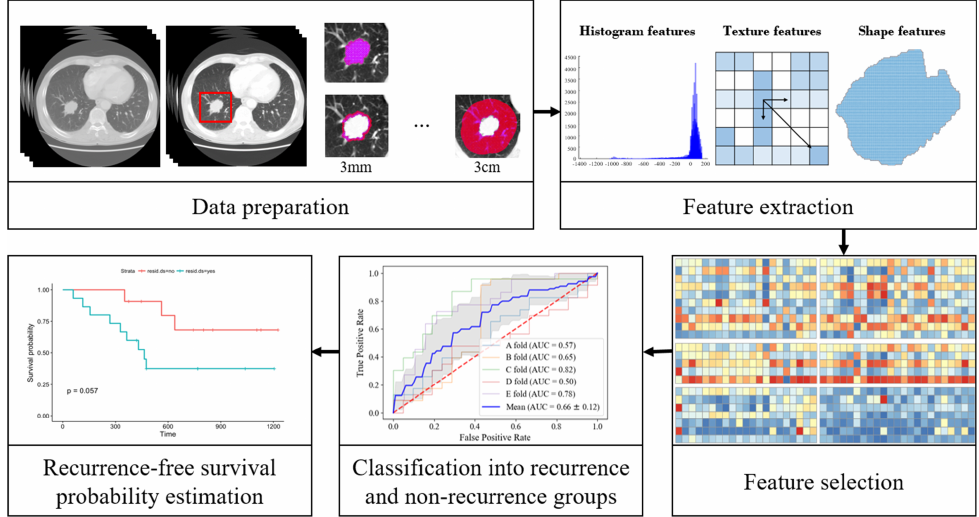
Figure 2. The pipeline of radiomic-based prediction model for 2-year recurrence-free survival prediction.